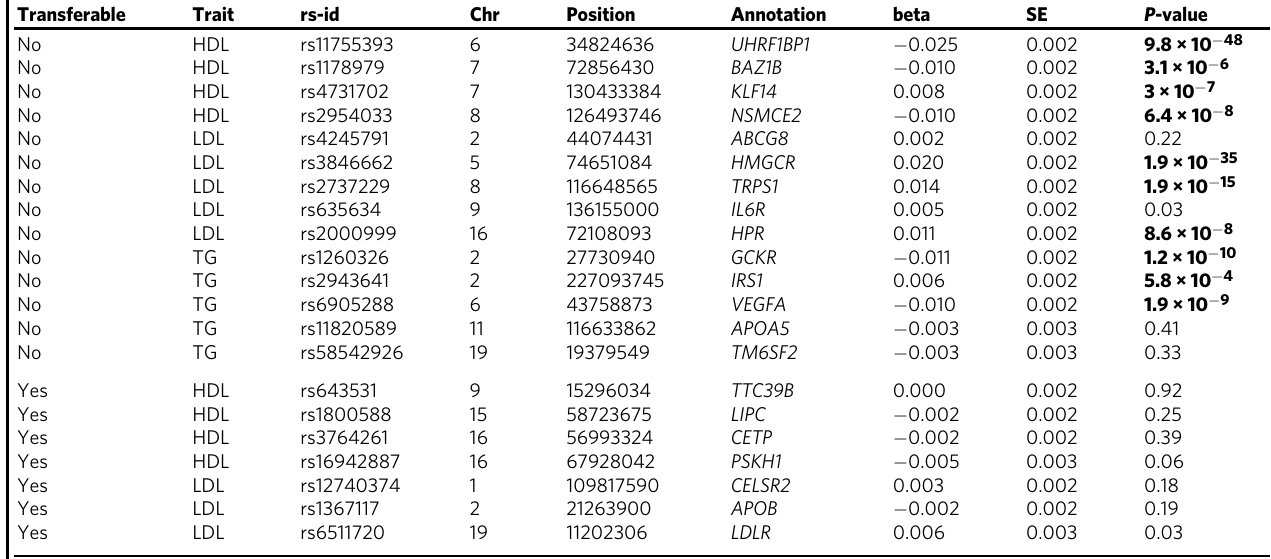
Table 3 Association of established lipid-associated loci with body mass index by whether the locus was transferable to APCDR- Uganda. BMI association results are based on N ≥ 484,680 samples from the meta-analysis between GIANT and UK Biobank